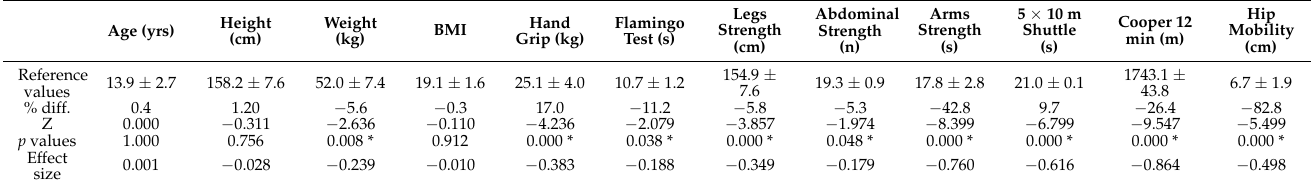
Table 3. Comparison of the fitness pre-test horse riders’ results with reference values.